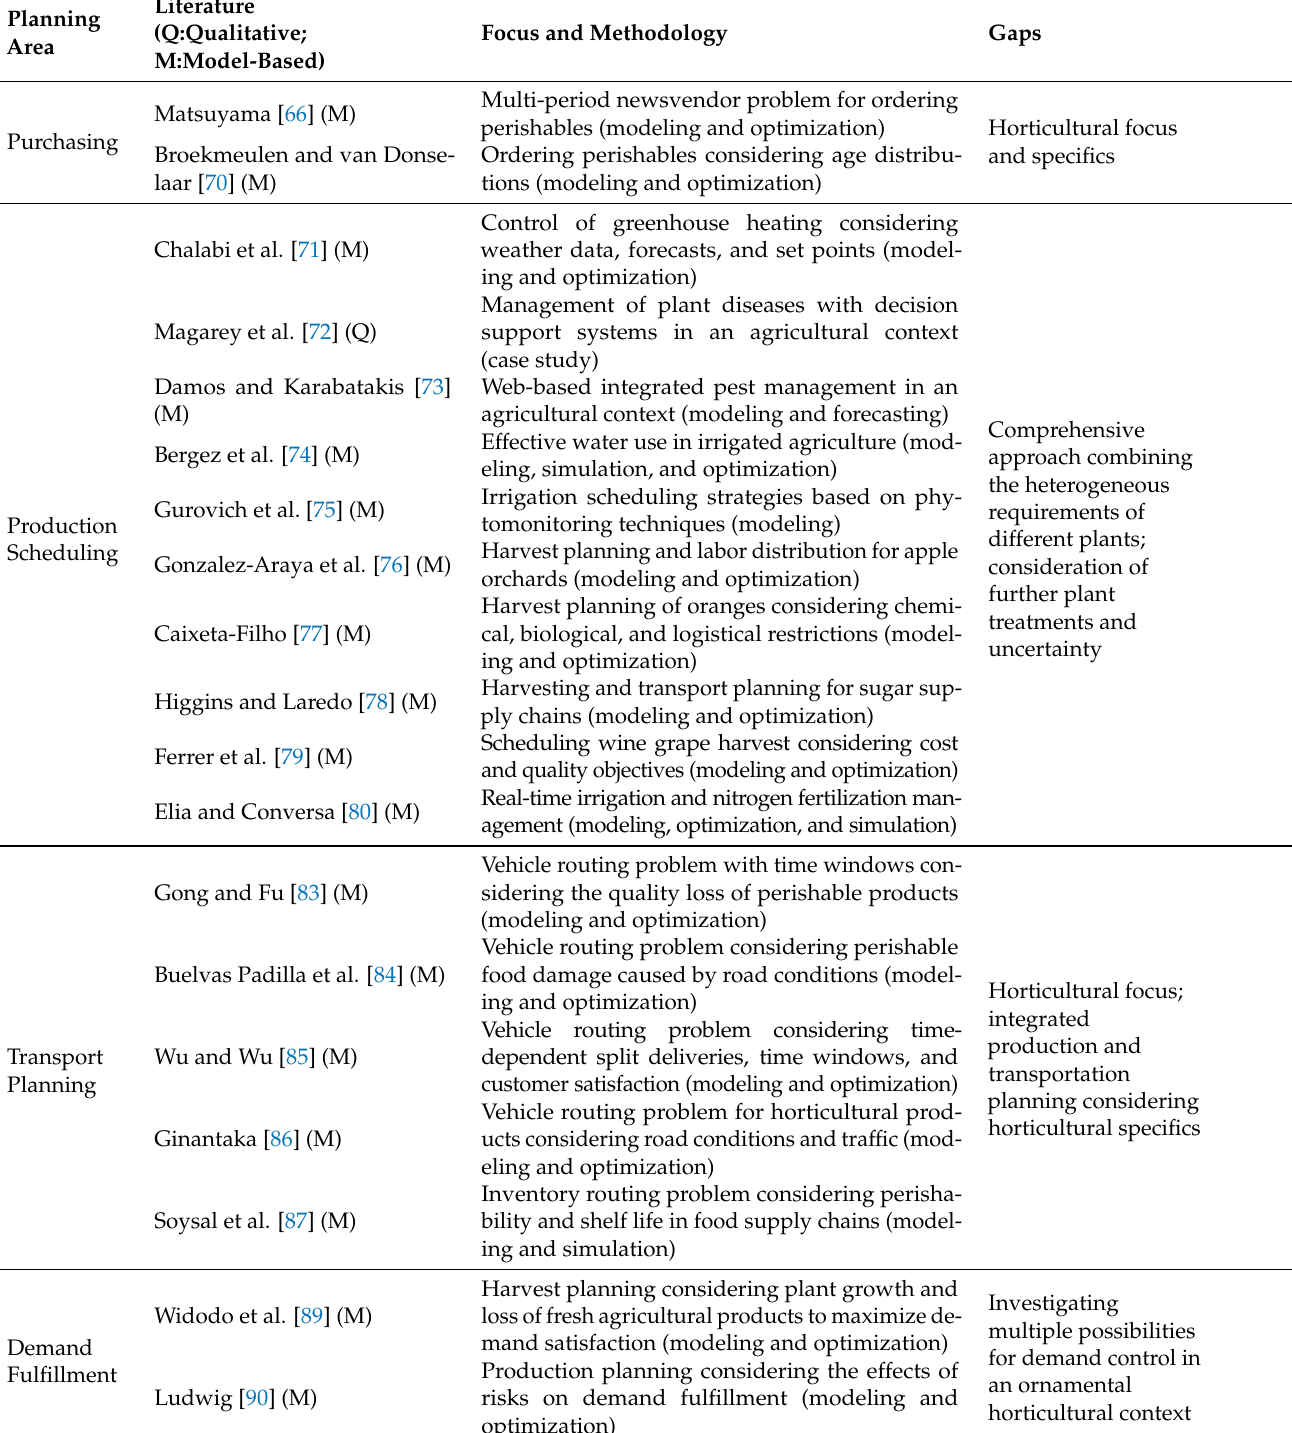
Table 4. Literature on operational supply chain planning in horticulture or aligned